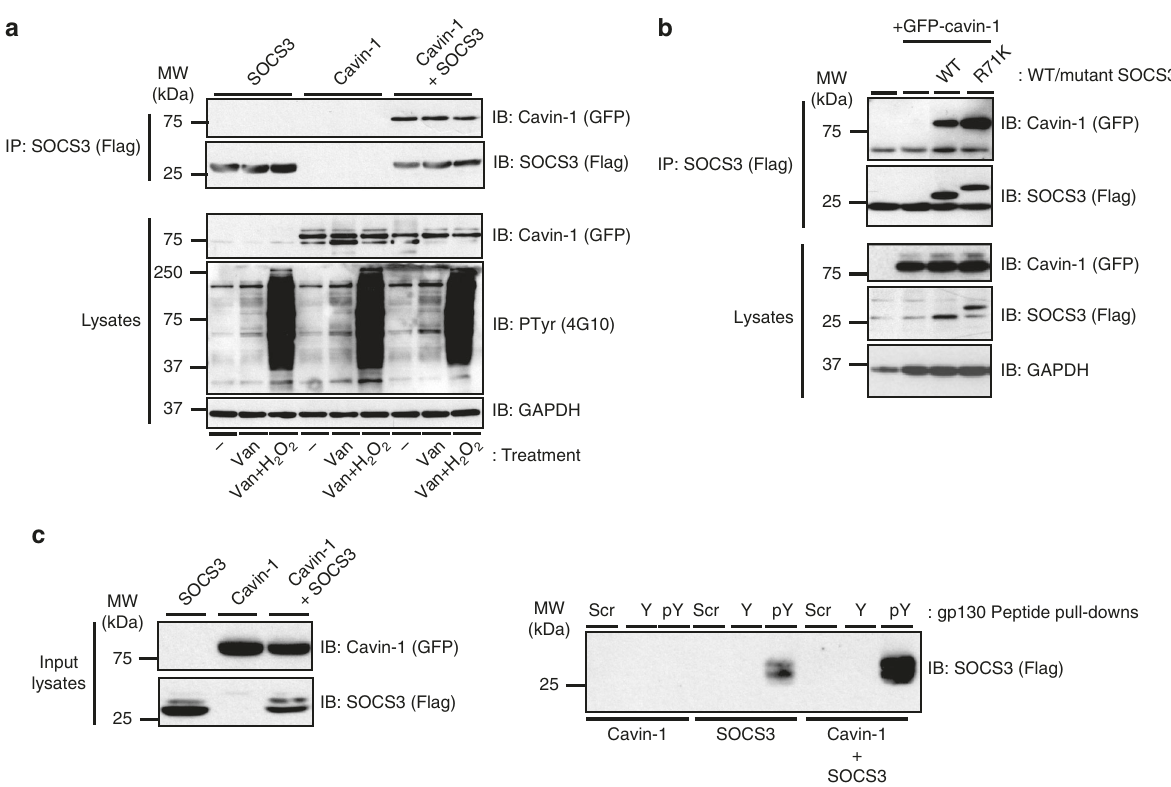
Fig. 4 Cavin-1 – SOCS3 interaction occurs independently of the PTyr binding capacity of the SH2 domain. a HEK293 cells transfected with expression constructs encoding Flag-SOCS3 and GFP-tagged cavin-1 as indicated were treated with or without Tyr phosphatase inhibitors sodium orthovanadate (Van: 1 mM) for 1.5 h and then hydrogen peroxide (H 2 O 2 : 0.2 mM) for an additional 30 min prior to harvesting. Protein-equalised soluble cell extracts were then processed by IP with anti-Flag M2-agarose beads prior to SDS-PAGE and immunoblotting with the indicated antibodies. Whole-cell lysates from the samples used in the IP were also fractionated by SDS-PAGE for immunoblotting in parallel. b Protein-equalised soluble cell extracts from HEK293 cells transfected with expression constructs encoding either WT or R71K-mutated Flag-SOCS3 and GFP-tagged-cavin-1 as indicated were processed by IP with anti-Flag M2-agarose beads prior to SDS-PAGE and immunoblotting with the indicated antibodies. Whole-cell lysates from the samples used in the IP were also fractionated by SDS-PAGE for immunoblotting in parallel. c Protein-equalised soluble cell extracts from HEK293 cells transfected with expression constructs encoding WT Flag-SOCS3 and GFP-tagged cavin-1 as indicated were incubated with 100 nM N-terminally biotinylated peptides corresponding to the Tyr759 motif of gp130 in its phosphorylated (pY) or non-phosphorylated (Y) forms or a scrambled control (Scr) and streptavidin – agarose beads prior to SDS-PAGE and immunoblotting with the indicated antibodies. Whole-cell lysates from the samples used in the pull-down were also fractionated by SDS-PAGE for immunoblotting in